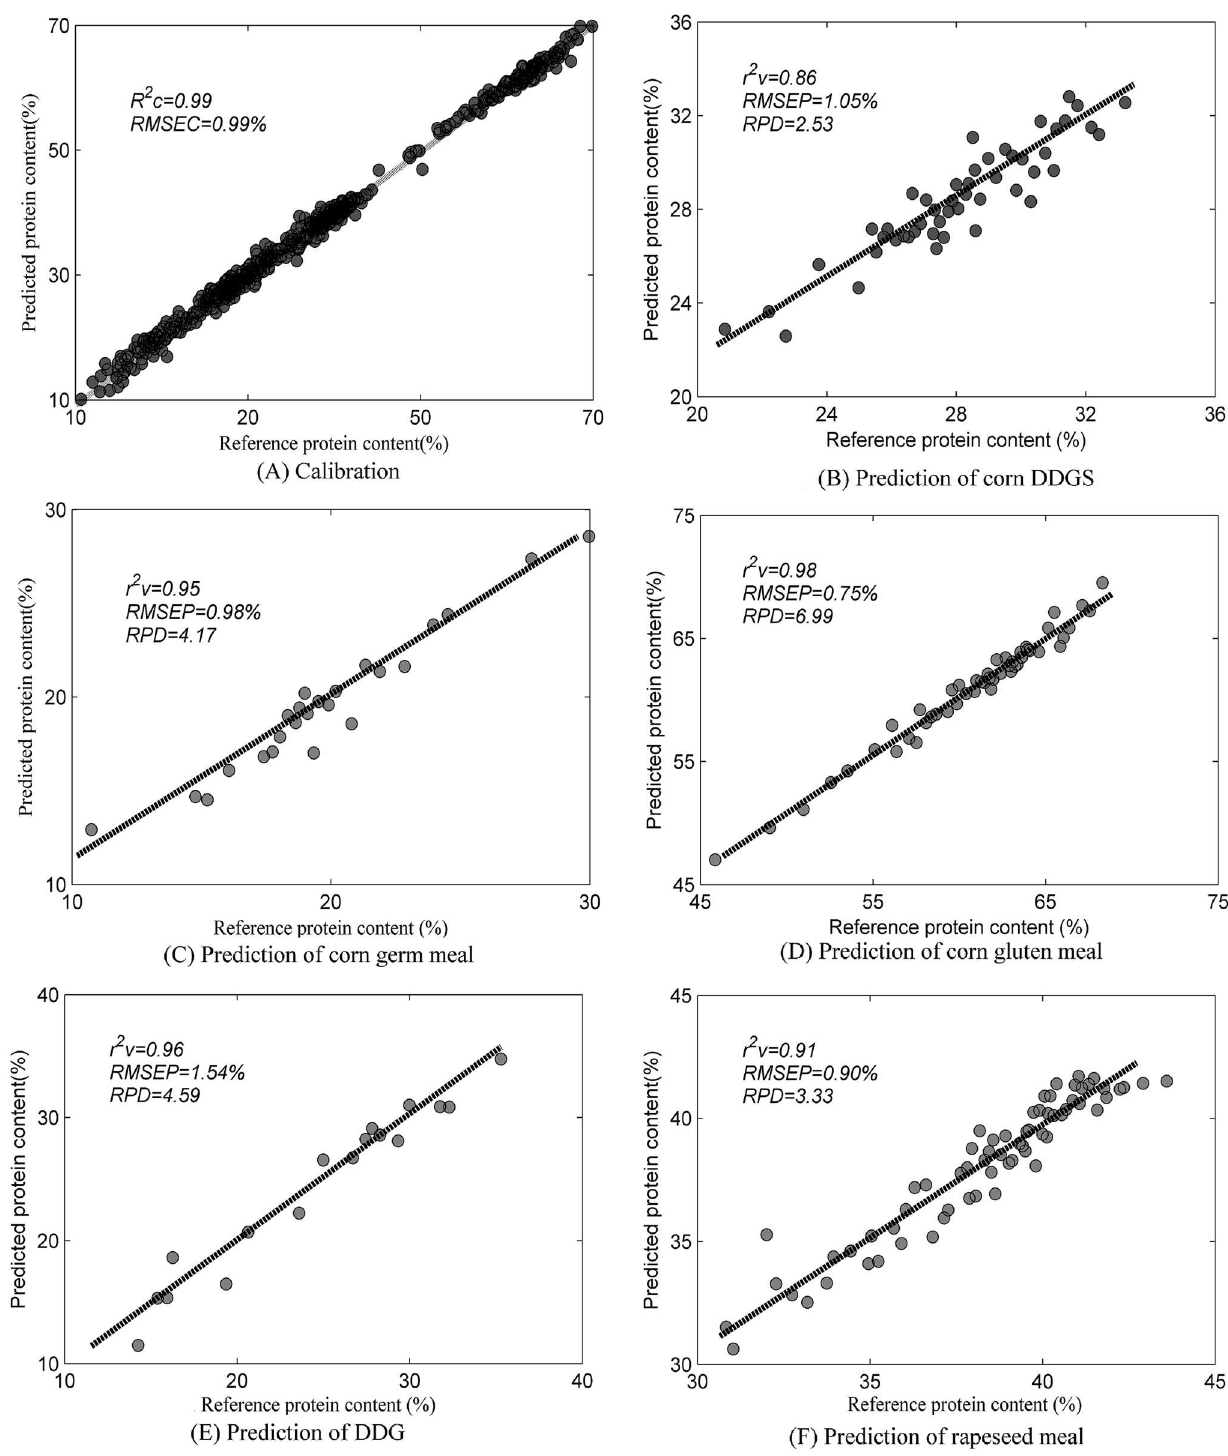
Fig 4. Calibration and validation results of VIP scores hybrid model. This hybrid model was constructed by 544 variables with VIP scores value bigger than 1.